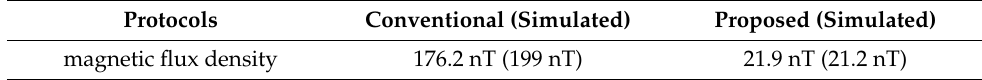
Table 1. Measured and simulated results for SS400. Figure 18. Deperming experiment results of SS400 depending on deperming protocols: ( a ) conventional protocol and ( b ) proposed protocol.